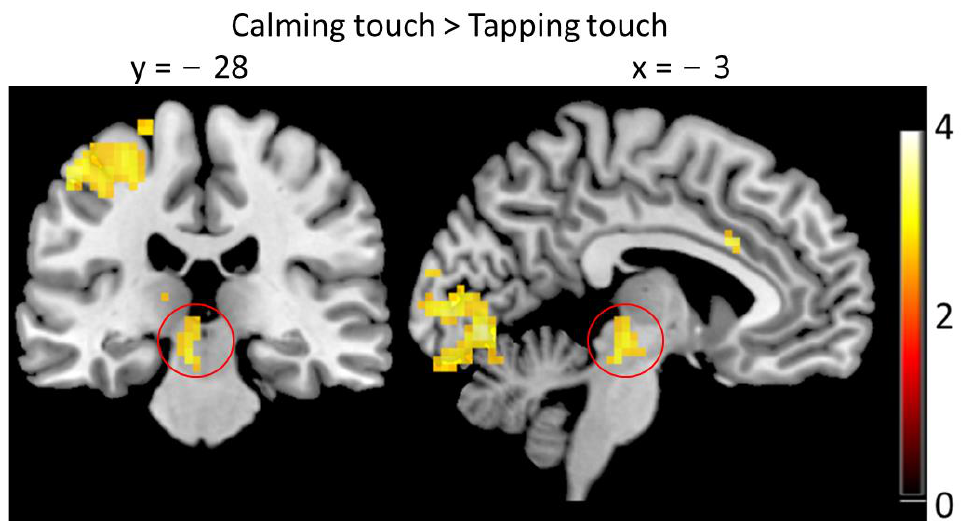
Figure 6. More activation in the PAG after calming touch than after tapping touch during the rating period (red circle), p < 0.001, clusters-size > 10 for display purpose. Additionally, visible clusters are not significant at the whole brain level and are not part of the